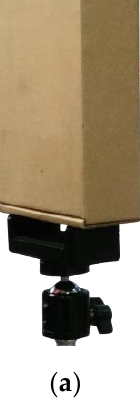
Figure 9. Hidden target: ( a ) outside; ( b ) inside; ( c ) imaging result.